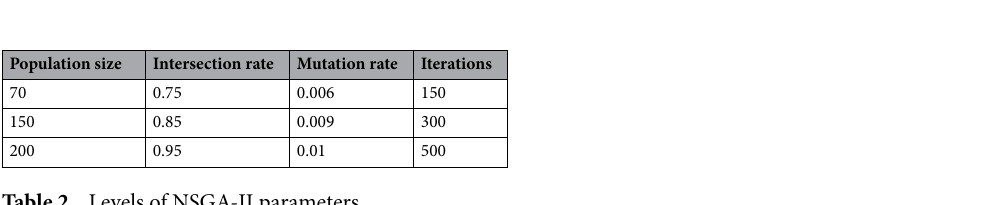
Table 2. Levels of NSGA-II